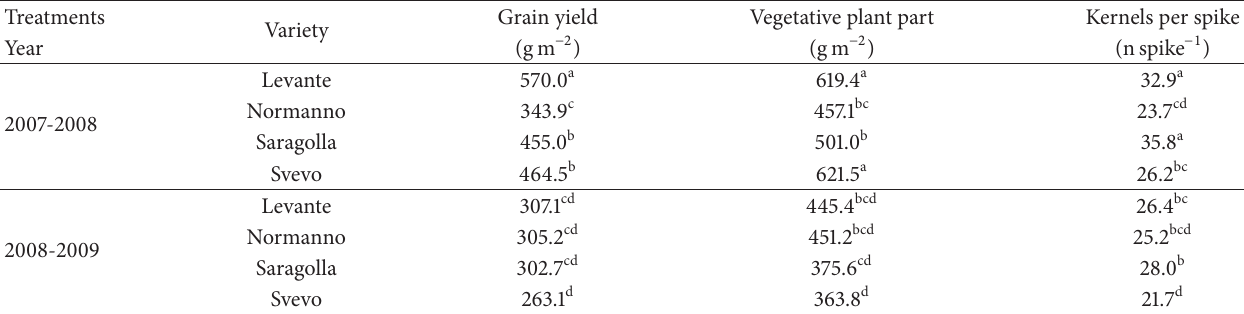
Within columns, numbers followed by the same letter are not significantly different at 𝑃 ≤